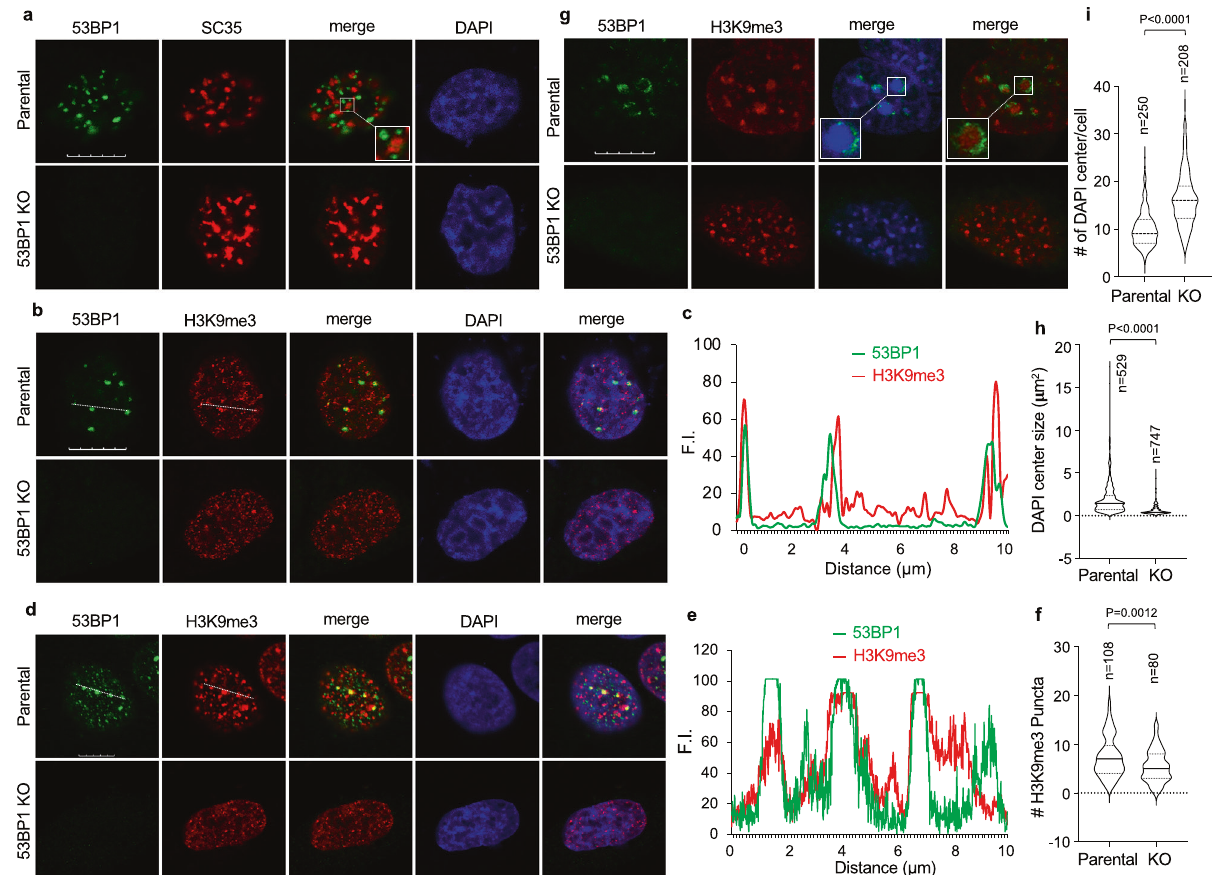
Fig. 2 53BP1 puncta localize at heterochromatin. Representative single z-plane confocal images from MDA-MB-231 ( a , b ), U-2 OS ( d ) and MEF ( g ) cells. Squares: enlarged areas. Dotted line scanning was shown for MDA-MB-231 ( c ) and U-2 OS ( e ) cells. f Violin plot of the number of H3K9me3 puncta (at or above the 25% percentile size of 0.746 vs 0.438 μ m 2 for parental and KO cells, respectively) in MDA-MB-231 cells from the indicated number of cells acquired from two independent experiments. Data represent mean, 25th, and 75th percentiles with the whiskers extending to the minimum and maximum values. h Violin plot of the size of MEF heterochromatin centers shown by DAPI staining from indicated number of puncta acquired from two independent experiments. The size of the median, 25%, 75% and 95% percentiles of heterochromatin centers in parental and 53bp1 KO MEFs were 1.450 vs 0.408, 0.725 vs 0.362, 2.356 vs 0.906 and 5.867 vs 2.174 μ m 2 , respectively. i Violin plot of the number of DAPI-indicated heterochromatin centers from indicated number of cells in ( g ) acquired from two independent experiments. Data represent mean, 25th and 75th percentiles with the whiskers extending to the minimum and maximum values. Unpaired two-tailed t test using Prism 9.0 was performed for f , h, and i with 95% con fi dence